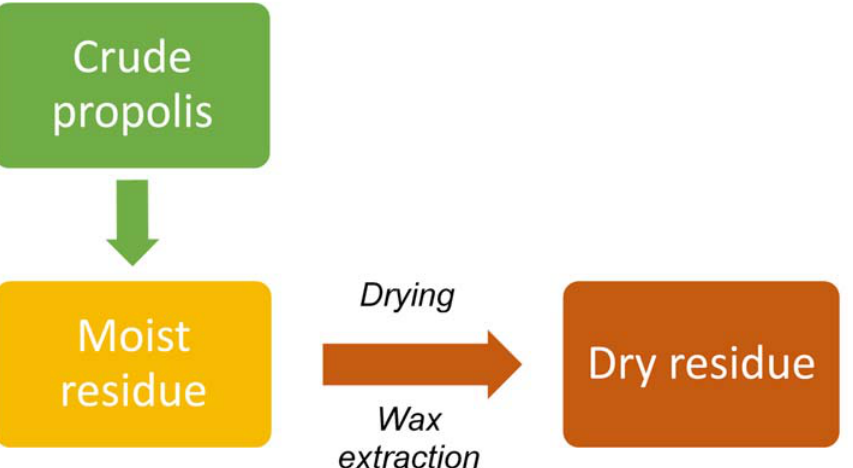
Figure 1. Flowchart of the processing to obtain propolis residues.